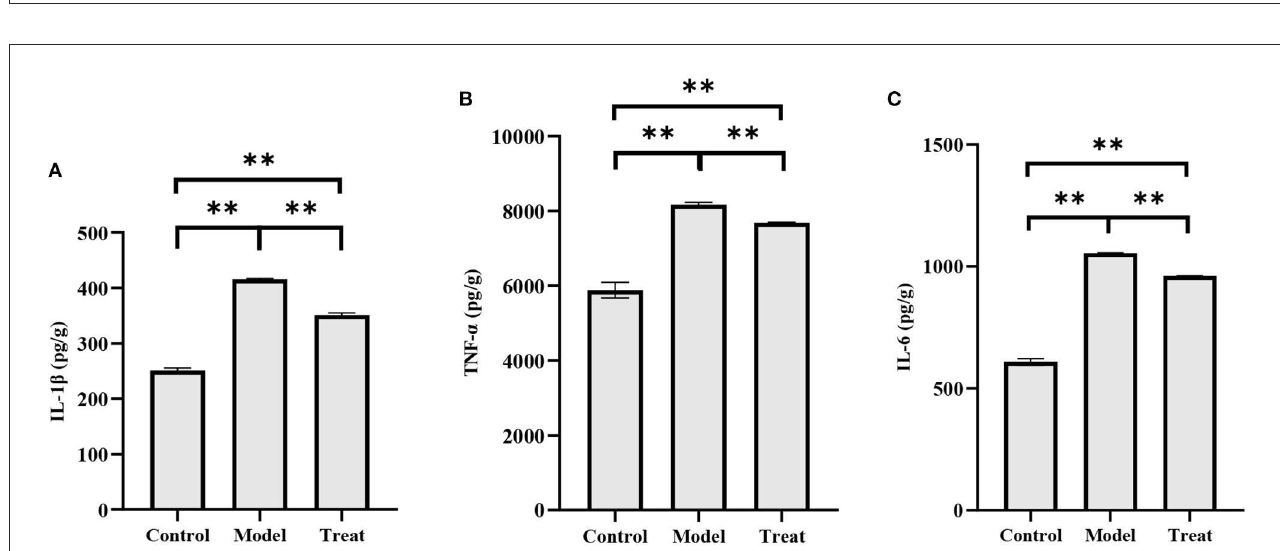
FIGURE8 ELISA results. Bar graphs show the mean results ± SD ( n = 3), (A) IL-1 β ; (B) TNF- α ; (C) IL-6, ** P <